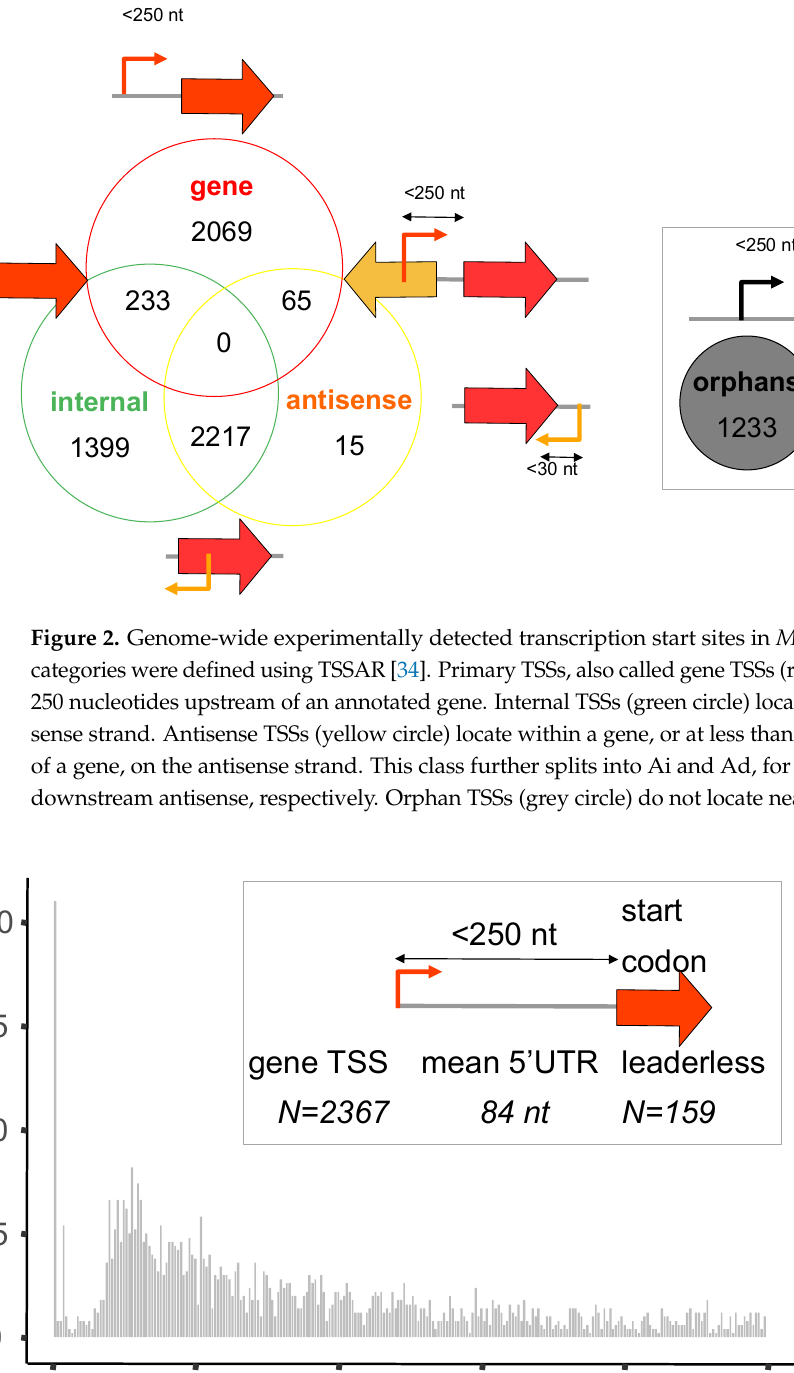
Figure 4. Remarkable nucleic acid motifs associated with M. extorquens DM4 gene expression. Tran- scription features (this work) and translation features [11] are shown. The −35 and −10 consensus sequences were deduced from TSS (P and IP) on the chromosome.